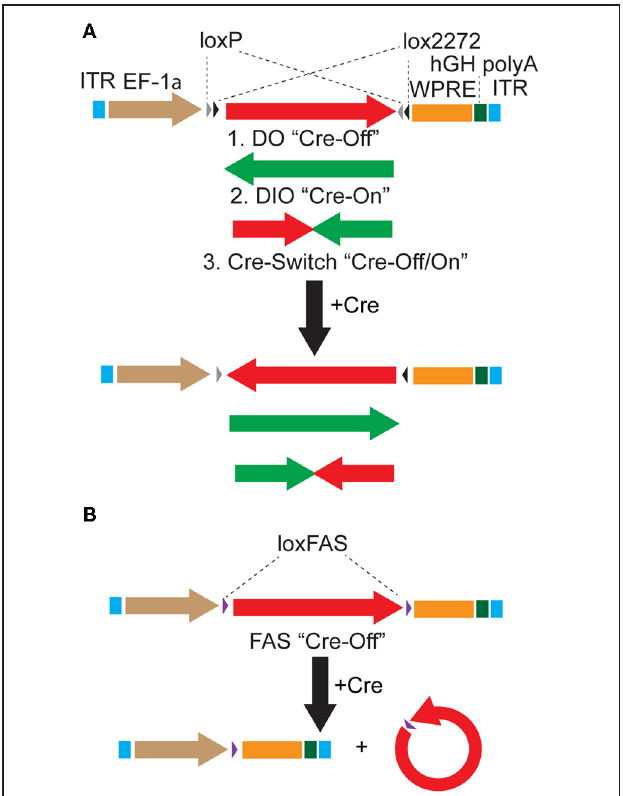
FIGURE 1 | Strategies to achieve Cre-dependent rAAV transgene expression. (A) Oppositely oriented loxP (gray triangle) and lox2272 (black triangle) sites permit Cre-mediated recombination and inversion of the flanked transgene with respect to the EF-1 α promoter. Downstream sequences stabilize the mRNA (woodchuck polyresponse element, WPRE) and trigger polyadenylation (human growth hormone polyadenylation, hGH polyA). After recombination, the transgene is flanked by one loxP and one lox2272 site, which do not recombine efficiently, effectively locking the transgene into position. The starting orientation of the transgene determines the Cre dependence of expression. The double-floxed orientation (1, DO) configuration, in which the open reading frame (ORF) of the transgene begins in the functional orientation with respect to the promoter, maintains expression only in cells lacking Cre (Cre-Off). In the opposite starting orientation, the double-floxed inverted (2, DIO) ORF must be recombined to be functional and expression is achieved only in Cre expressing cells (Cre-On). A single transgene containing two ORFs oriented oppositely with respect to each other and separated by stop codons (3, Cre-Switch) switches expression between the two ORFs depending on Cre expression. For Cre-Switch transgenes, the first, forward orientated ORF is expressed in Cre negative cells whereas the second, inverted ORF is activated in Cre positive cells. ITR = inverted terminal repeats. (B) Cre-Off control of transgene expression can also be achieved by Cre-based excision of the ORF using alternative lox FAS sites. loxFAS sites flank the ORF and are oriented in the same direction such that the flanked sequence is excised by